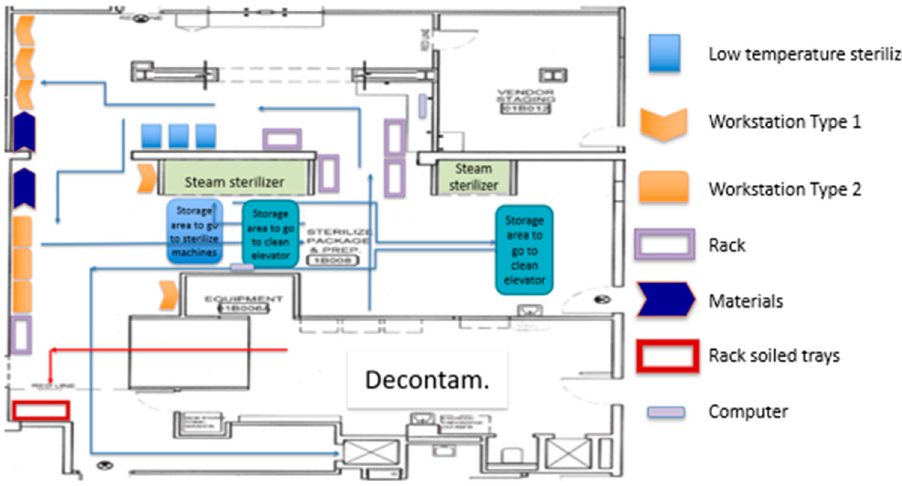
Figure 6. Current State SPD plant layout .